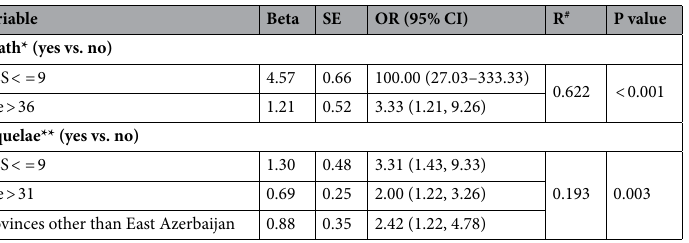
Table 5. Logistic regression analysis for independent predictive factors of death and sequelae in methanol outbreak based on on-arrival sociodemographic variables. # Nagelkerke R Square. *All variables with p value less than 0.2 were entered in the model including: ingestion time to admission, age, province mortality rate (high vs. low), schooling categorization (more than 12 years; yes vs. no), Glasgow Coma Scale (GCS). **All variables with p value less than 0.2 were entered in the model including: ingestion time to admission, age, province sequelae rate (high vs. low),